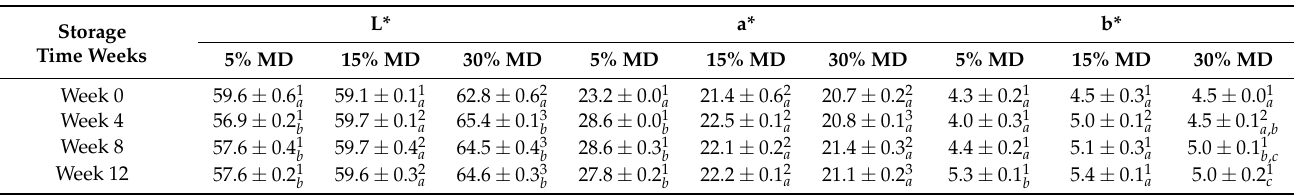
Table 3. Hunter color parameters for raspberry foam samples with 5% ( w / w ) PP + 2.5% ( w / w ) P at various MD